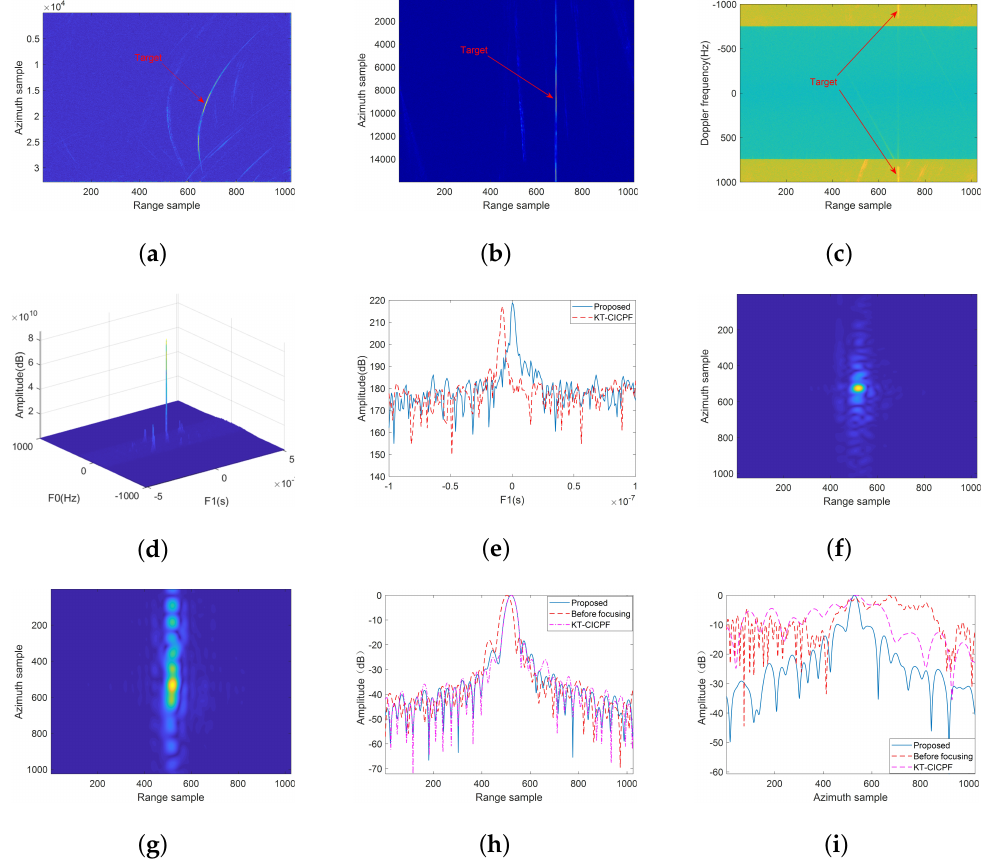
Figure 11. Processing result of T1. ( a ) Target signal after clutter suppression. ( b ) Hough+SOKT RCMC; ( c ) Range-Doppler domain. ( d ) F 0 – F 1 parametric plane. ( e ) F 0 estimate. ( f ) Imaging by proposed method (16 × upsampling). ( g ) Imaging by KT-CICPF (16 × upsampling). ( h ) Slice in range. ( i ) Slice in